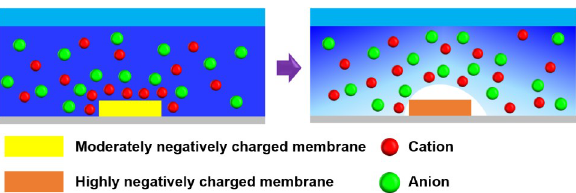
Fig 1. Formation of IDZ according to SZP of a membrane. Schematics illustrating IDZ formation around the membrane. Cations (red circle) are attracted toward a negatively charged surface, whereas anions (green circle) are repelled from the surface of a moderately charged membrane (yellow square) when the membrane is exposed to an ionic solution. Ion depletion zone is rarely formed in this case. However, when a highly negatively charged membrane (orange square) is exposed to the ionic solution, formation of IDZ (white area) is